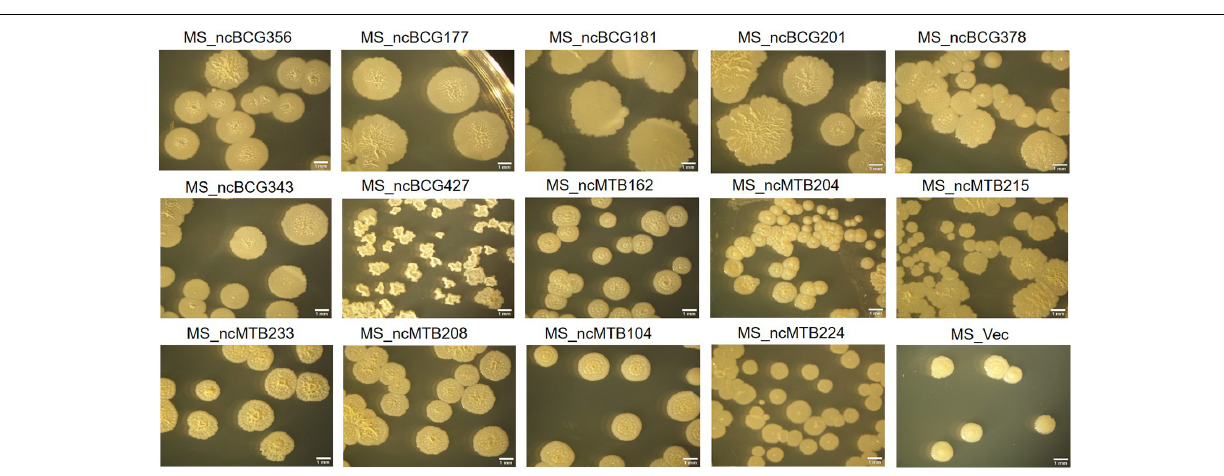
methyltransferase, lppG was a lipoprotein, PPE56a belongs to the PPE family with unknown